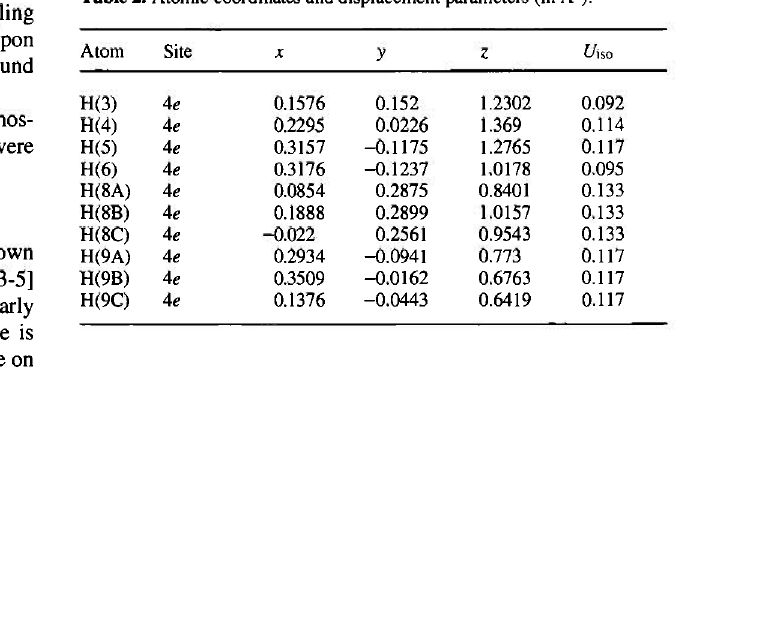
Table 2. Atomic coordinates and displacement parameters (in A 2